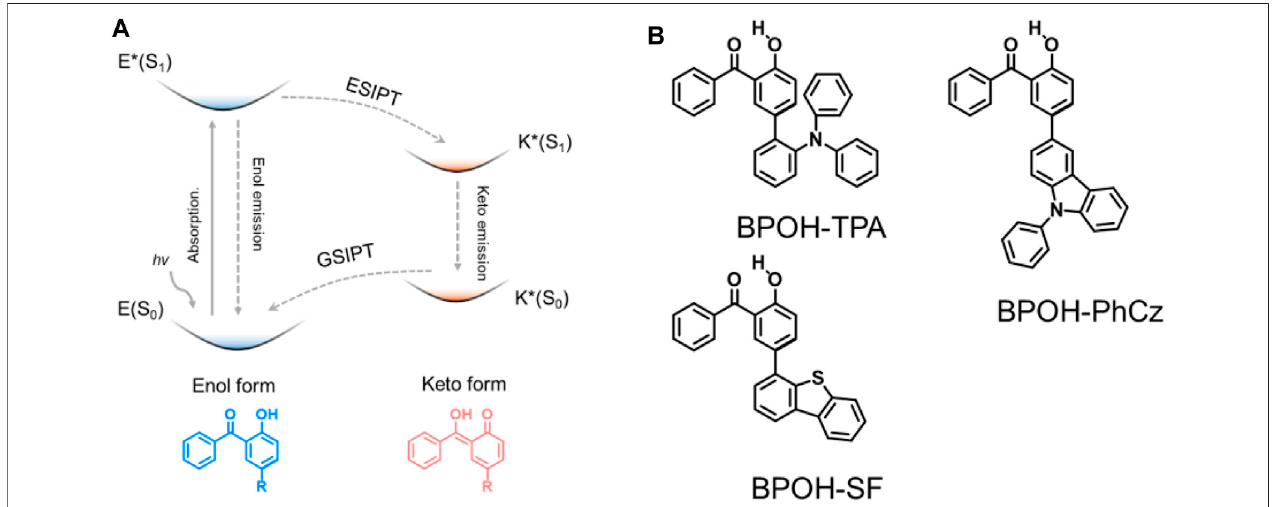
FIGURE 1 | (A) Schematic of the ESIPT mechanism and (B) chemical structures of BPOH-TPA, BPOH-PhCz, and BPOH-SF.